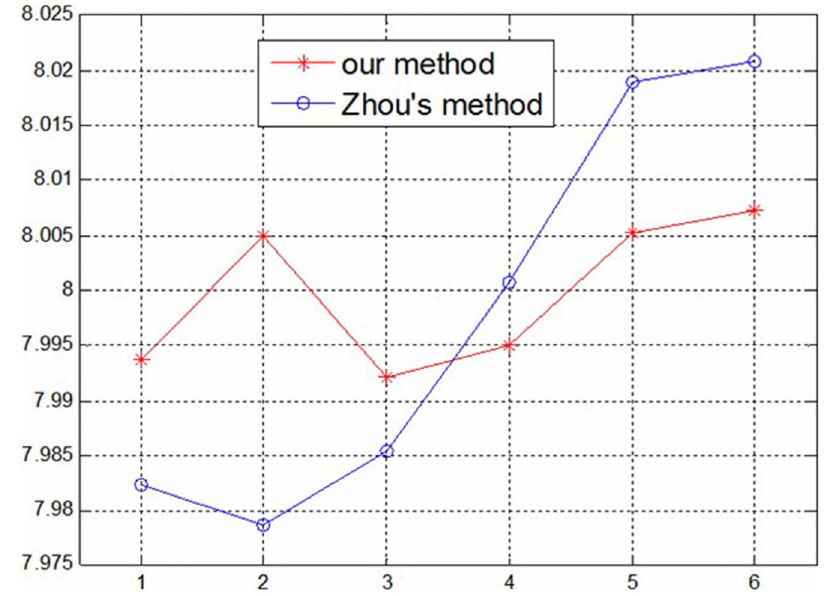
Figure 17. The measurement results of 8 mm Gauge block.